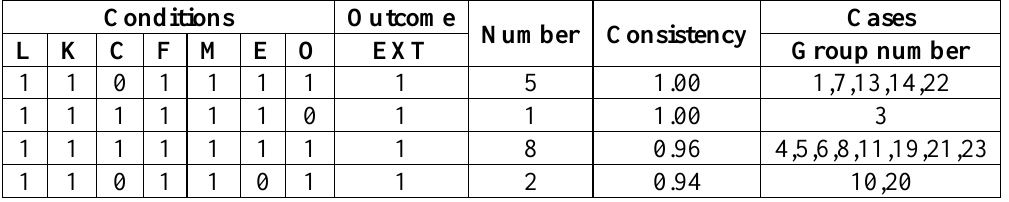
Table A3.4. Truth table of fsQCA for the analysis of sufficiency for the group success. L=Leader, K=Knowledge generator, C=Connector, F=Follower, M=Moralist, E=Enforcer,